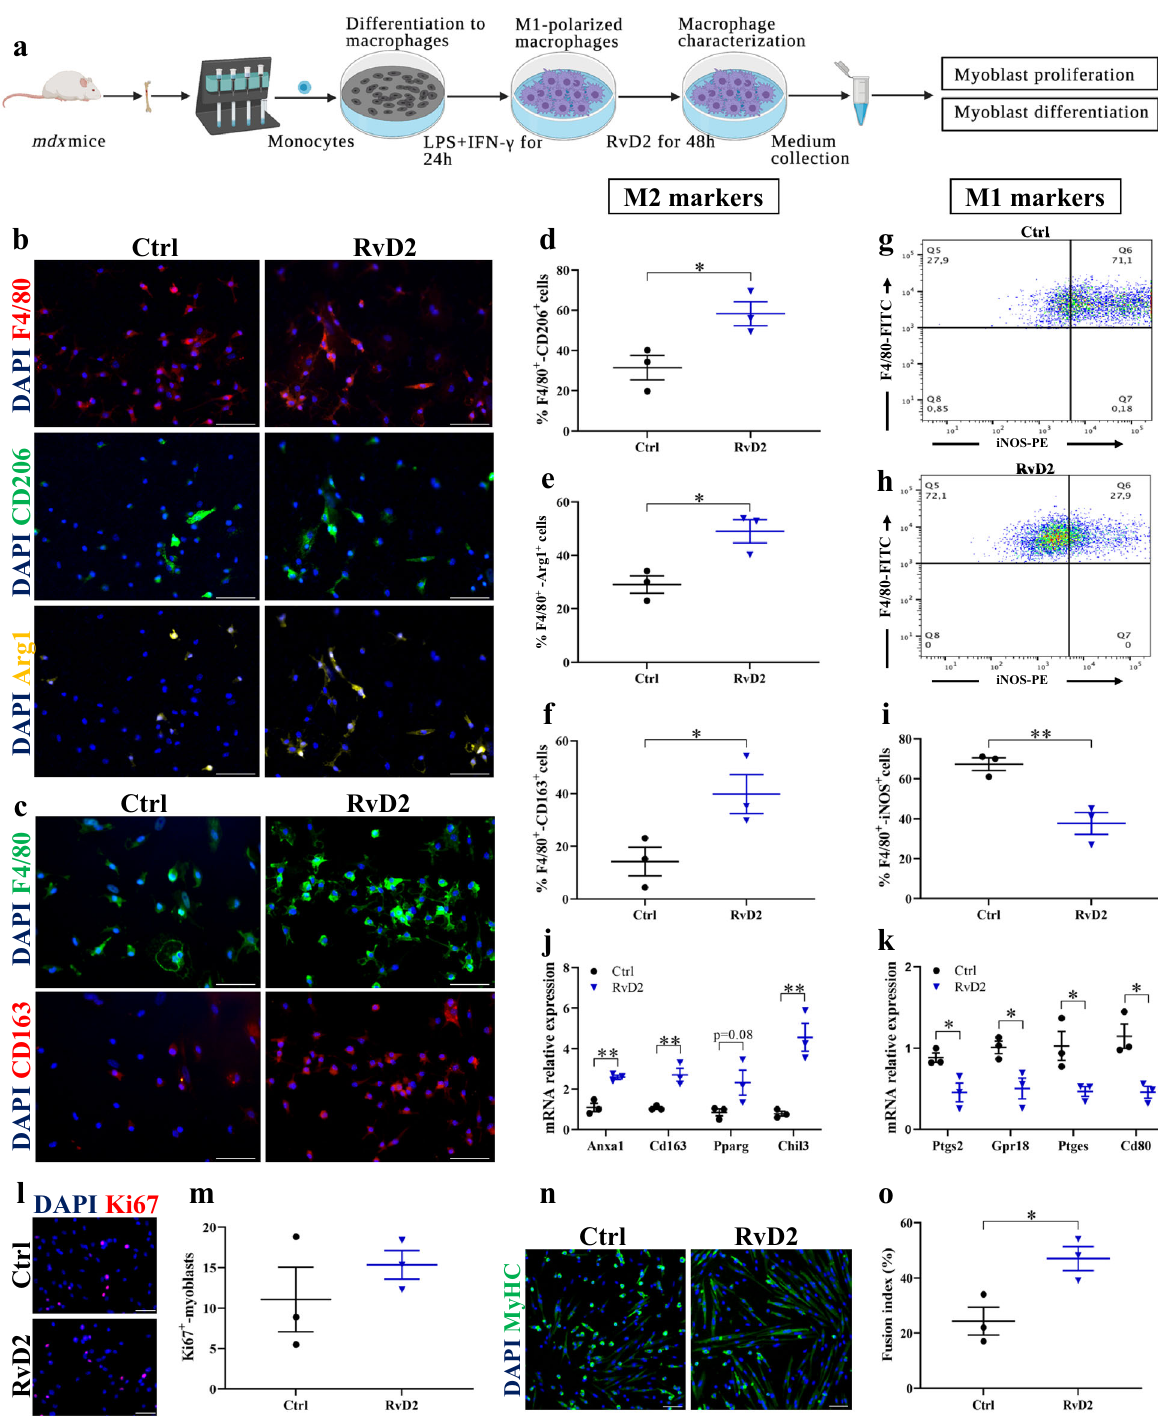
macrophage marker (Fig. 1g – i) 34 . Considering that macrophages are on a continuum of polarization states, we further assessed by qPCR the expression of several key genes that were identi fi ed by transcriptome analysis to be speci fi cally expressed in the in